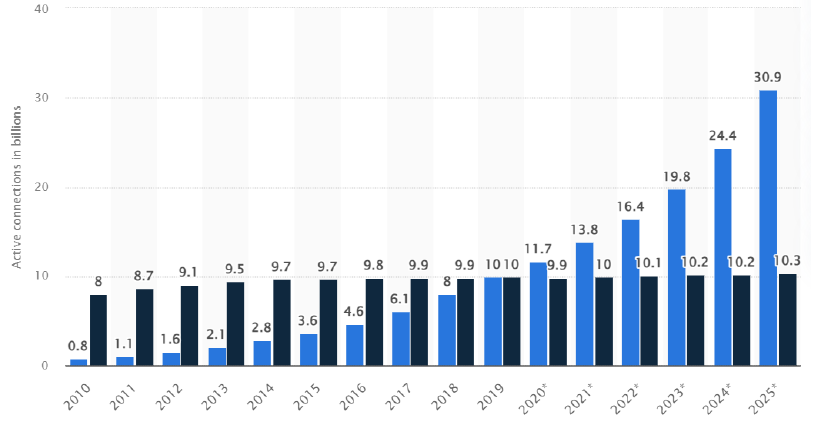
Figure 1. IoT and non-IoT connections